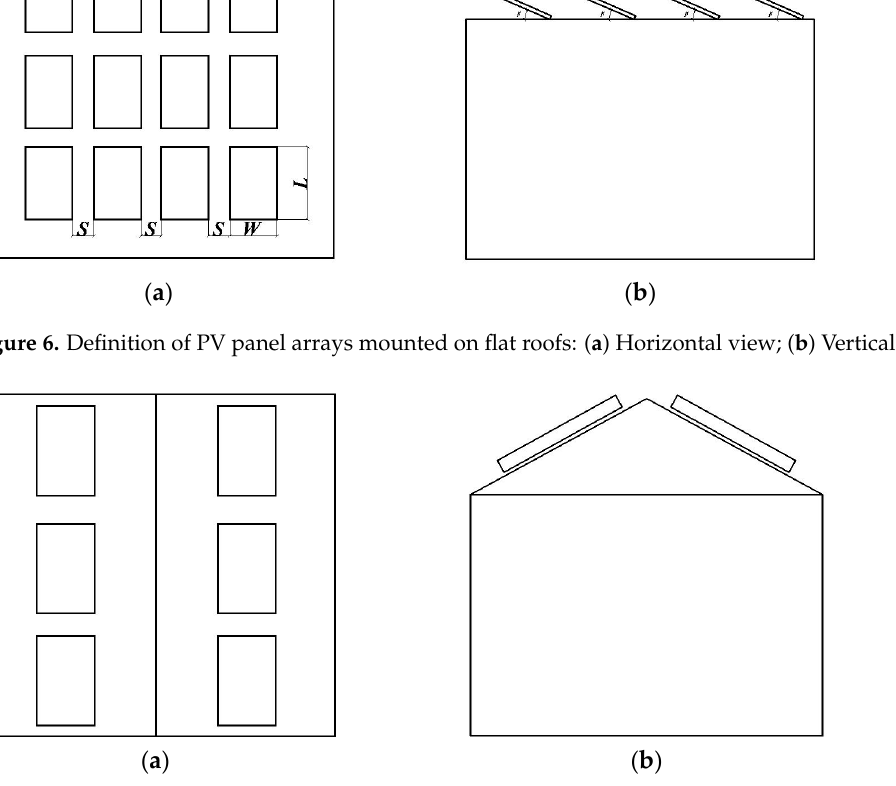
Figure 7. De fi nition of PV panel arrays mounted parallel to roofs: ( a ) Horizontal view; ( b ) Vertical view.